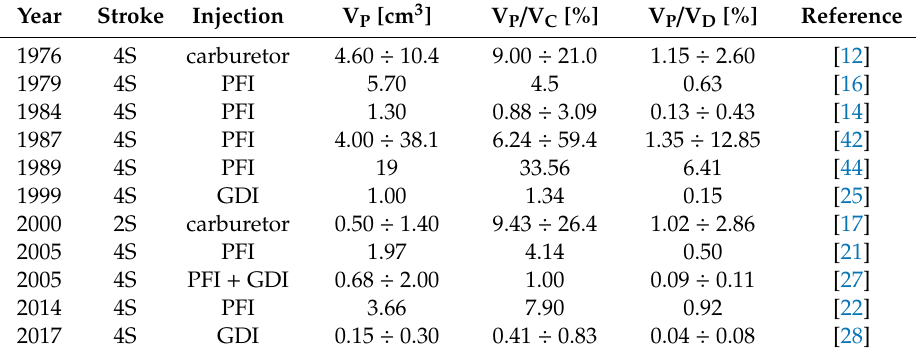
Table 2. Volumes of the passive prechambers for gasoline engines known to the